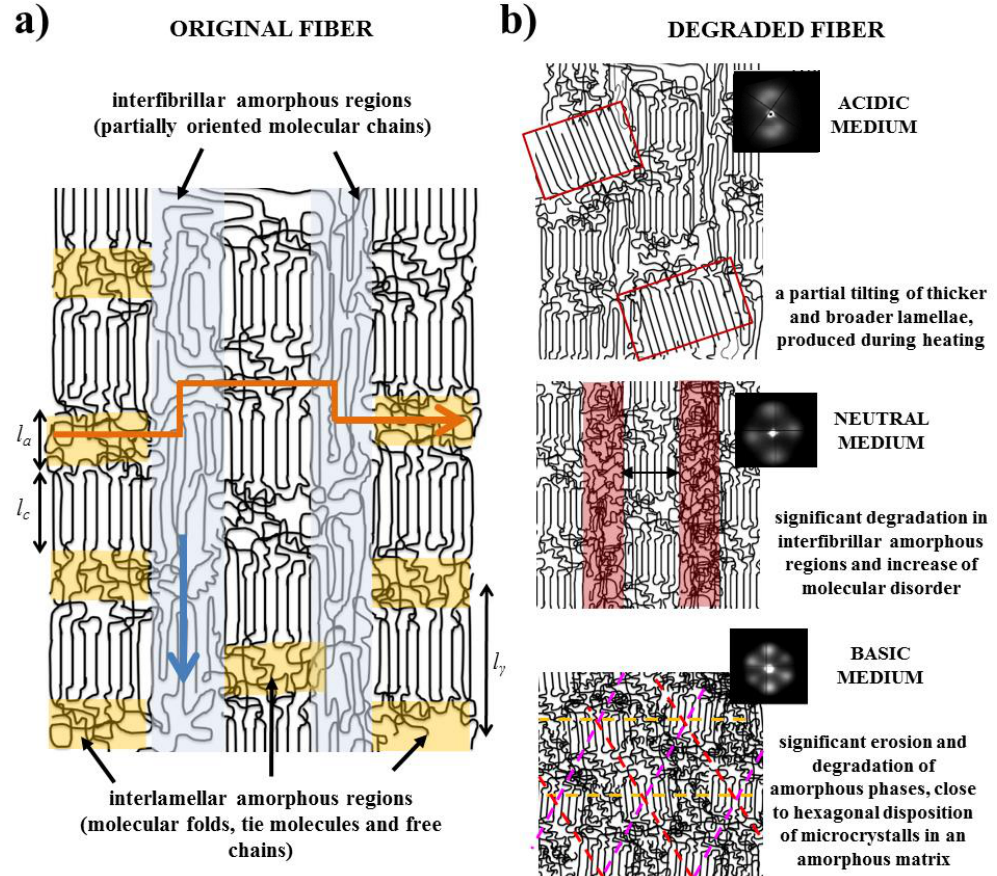
Figure 8. ( a ) Scheme showing the presence of oriented lamellar crystals embedded in interlamellar (yellow) and interfibrillar (blue) amorphous domains. Blue and orange arrows indicate the attack able to generate longitudinal and circumferential cracks, respectively; ( b ) Schemes showing the distinctive morphological changes that occurred during heating of samples previously degraded in acidic, neutral, and basic media. For the sake of completeness representative SAXS patterns taken during a heating scan are also